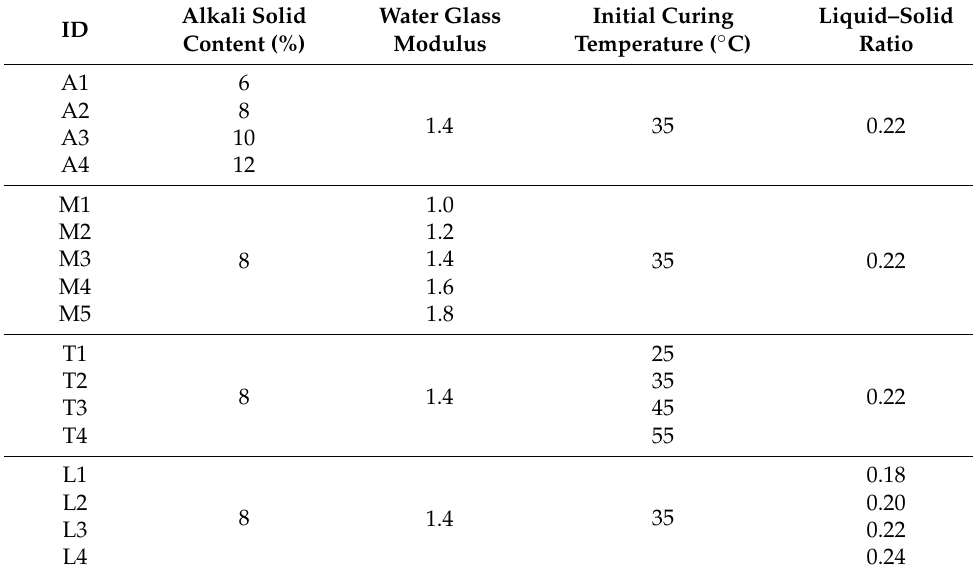
Table 2. Single-factor experimental